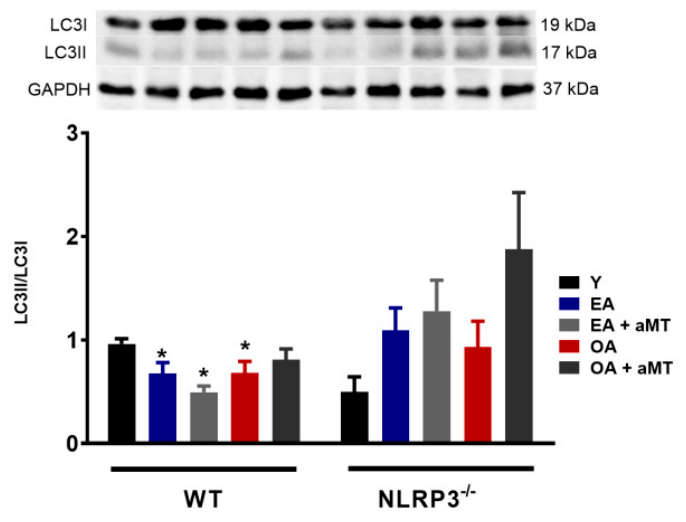
Figure 3. Changes in autophagy in WT and NLRP3 − / − mice during aging and melatonin treatment. LC3II / LC3I ratio. Experiments were performed in hearts of young (Y), early-aged (EA), early-aged with melatonin (EA + aMT), old-aged (OA), and old-aged with melatonin (OA + aMT) wild type and NLRP3 − / − mice. Data are expressed as means ± SEM ( n = 7 animals / group). * p < 0.05 vs. Y.